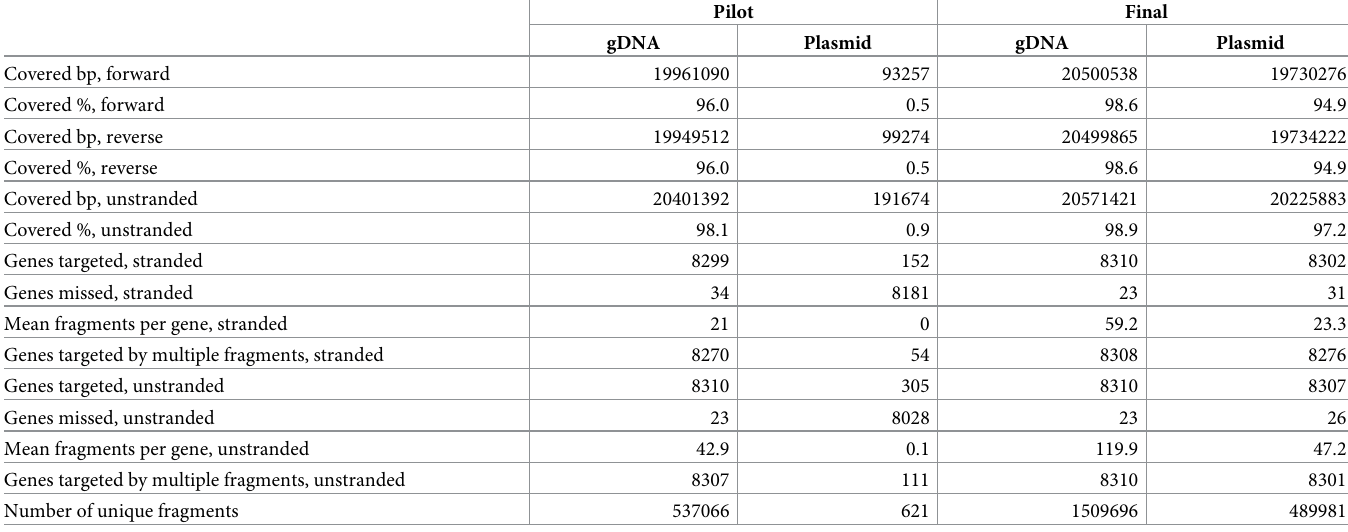
Table 1. Library coverage analysis. Analysis of coverage in the pilot and final gDNA fragments, and the pilot and final plasmid libraries. Genomic coverage (reported as bp covered, forward, reverse, and unstranded) was calculated using fragments of the appropriate orientation, inferred from mapped reads and the coverage function in the GenomicRanges R/Bioconductor package. The total number of covered bp are indicated, and the corresponding percentage of the HM1:IMSS reference genome that this represents. Forward fragments are in the same orientation as genes that are in the forward orientation in the reference genome. Reverse fragments are in the same orienta- tion as genes that are in the reverse orientation in the reference genome. Stranded fragments are in the same orientation as genes, and are the combined total of both for- ward and reverse fragments. Unstranded fragments are the total number of fragments, both in the same orientation as genes in the reference genome and in the opposite orientation as genes. Genes that are targeted are those with at least one unique fragment with greater than or equal to 27nt that overlaps the gene. Genes that are missed are those that do not fit the criteria for targeted genes. Genes that are targeted by multiple fragments are those with two or more unique fragments. Counts were calculated using the countOverlaps function in the GenomicRanges package and annotation from AmoebaDB. The number of unique fragments is the total number of unique frag- ments in each